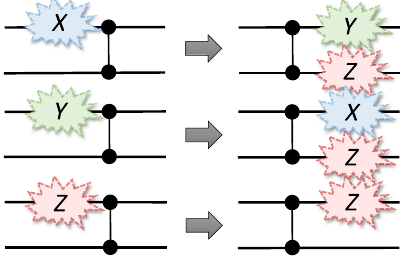
FIG. 2. Error propagation through ZZ gates. The propagation of a Pauli- X ð Y Þ error leads to a conversion of the error into a Y ð X Þ -type error, respectively, while a Z error is triggered on the second qubit. A Z error commutes with the ZZ gate and thereby propagates through the gate without affecting the other